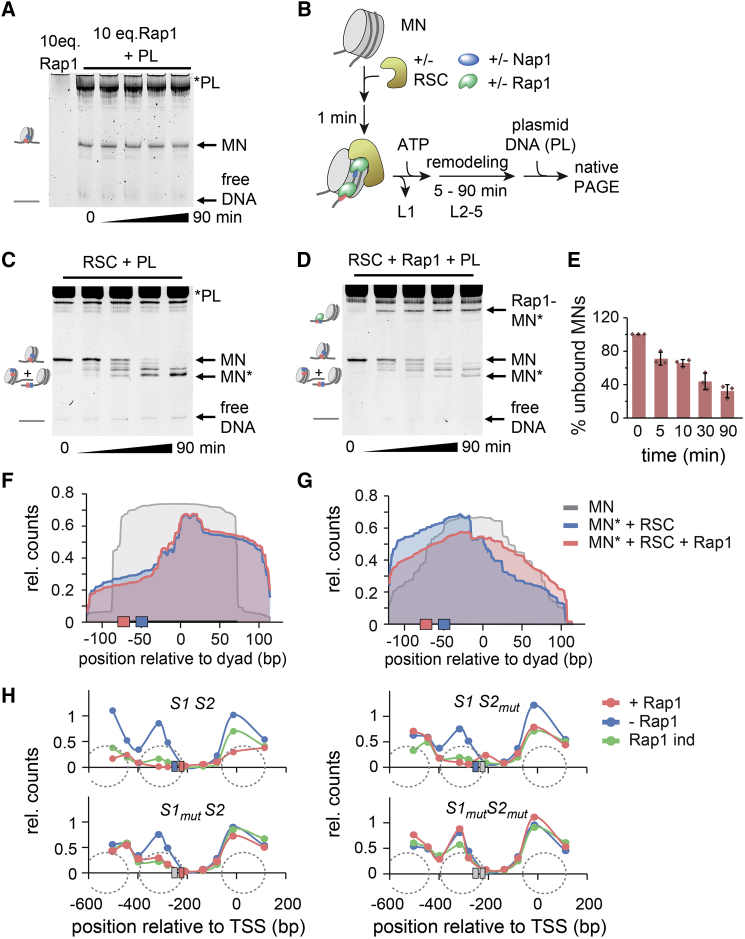
RSC Enables Stable Rap1 Binding by Exposing Binding Sites(A) Native PAGE analysis of Rap1 binding for indicated times followed by incubation with competitor plasmid DNA (PL). L1 and L2–L5: lanes in (A) and (C) and (D).(B) Scheme of RSC remodeling assay. Note that Nap1 is not strictly required in these experiments (Figure S7C).(C) Native PAGE analysis of remodeling assays; MN∗, remodeled mononucleosome.(D) Native PAGE analysis of remodeling assays in the presence of 10 eq. of Rap1.(E) Integrated unbound nucleosome bands from (D) (n = 3; error bars SD).(F) MNase-seq results from RSC remodeling assays for 601 nucleosomes (P3_S1S2). Gray, nucleosome start position; blue, RSC remodeling for 90 min in absence of Rap1; red, RSC remodeling for 90 min in presence of 10 eq. Rap1. Shown are reads normalized to number of total reads.(G) Same as in (F) but for RPL30 nucleosomes (P3_RPL30).(H) Effect of Rap1 binding on nucleosome stability at the RPL30 promoter in yeast. Nucleosome positions were determined using qPCR after MNase digestion of chromatin. Promoters analyzed contained both Rap1 binding sites (S1S2), S1 mutated (S1mutS2), S2 mutated (S1S2mut), or both binding sites mutated (S1mutS2mut). Data shown are for cells where Rap1 is present (Rap1+, red), Rap1 has been depleted from the nucleus for 1 h by anchor-away (Rap1−, blue), and where Rap1 has been re-introduced for 2 h following depletion by expressing a RAP1 construct from an inducible promoter (Rap1 ind, green).See also Figure S7 and Table S7.